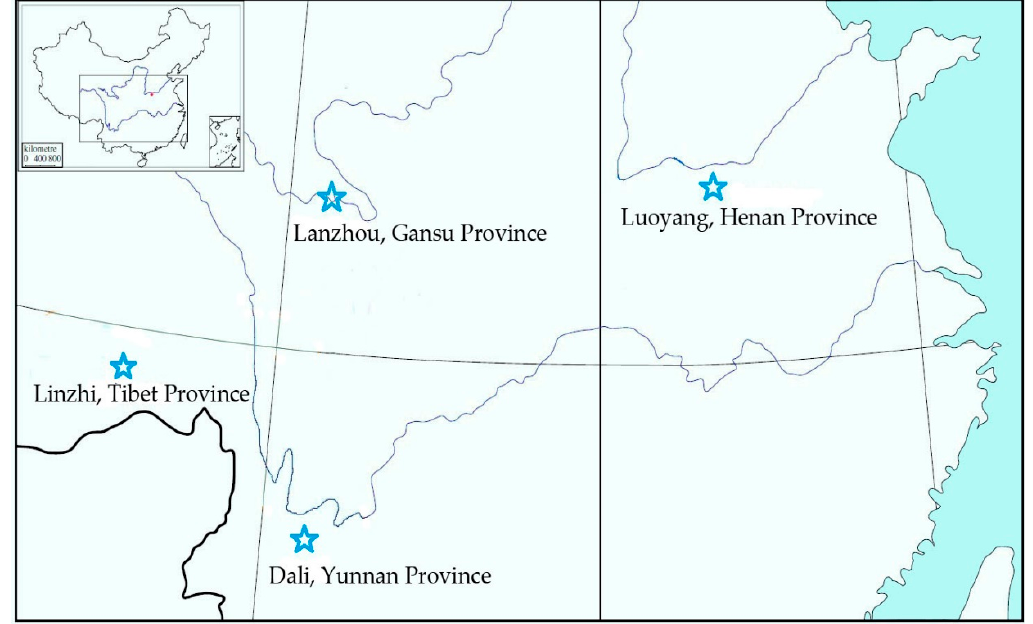
Figure 1. Collection sites of ten wild tree peonies leaves. Luoyang: P. qiui ; P. decomposita ; P. jishanensis ; P. ostii ; P. cathayana . Lanzhou: P. rockii ; P. delavayi . Dali: P. lutea . Linzhi: P. ludlowii . Table 1. Sources of ten wild tree peonies used for the study.